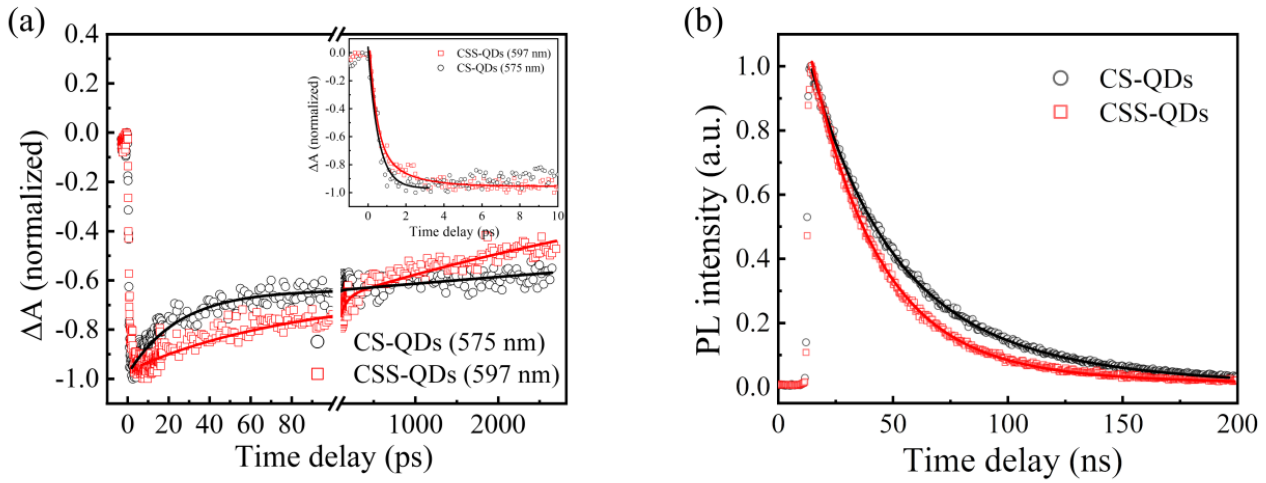
Figure 5. Normalized dynamics of band-edge bleach signals ( a ) and PL ( b ) for the CS − QDs and CSS − QDs.